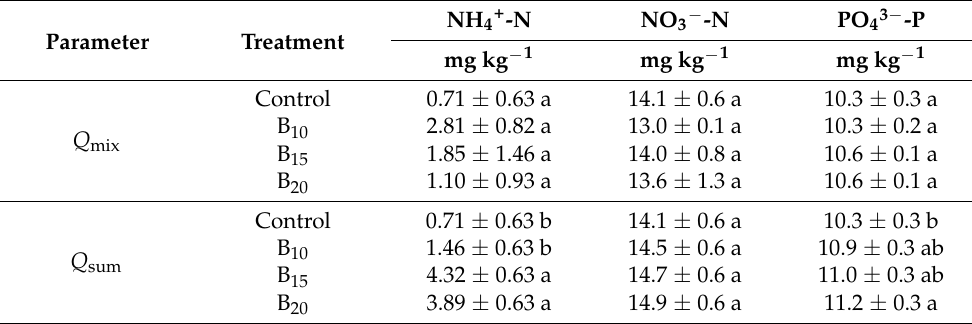
Parameters: Q mix , NH 4+ -N, NO 3 − -N, or PO 43 − -P concentration in soil (including soil mixtures with compound fertilizer, calcium superphosphate, and/or PSB); Q sum , summation of NH 4+ -N, NO 3 − -N, or PO 43 − -P concentra- tion in soil and other individual materials (including compound fertilizer, calcium superphosphate, and/or PSB). Treatments: Control, no fertilization; B 10 , 10% PSB-based fertilization; B 15 , 15% PSB-based fertilization; B 20 20% PSB-based fertilization. Data are expressed as means ± SD ( n = 3). Per column in the same row, data followed by different lowercase letters (e.g., a, b, c, etc.) indicate significant ( p < 0.05) differences among the rates of PSB application alone based on the Tukey